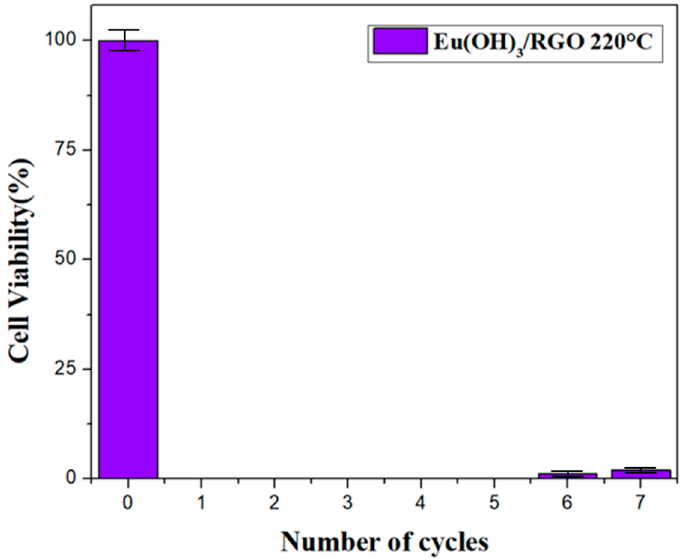
Figure 11. Reusability of 8 µ g/mL Eu(OH) 3 nanocomposites against 100 mL of E. coli (10 4 CFU/mL) at 37 °C and 120 RPM for 30 min . Error bars represent the standard deviations, n = 3, n= numbers of experimental results.